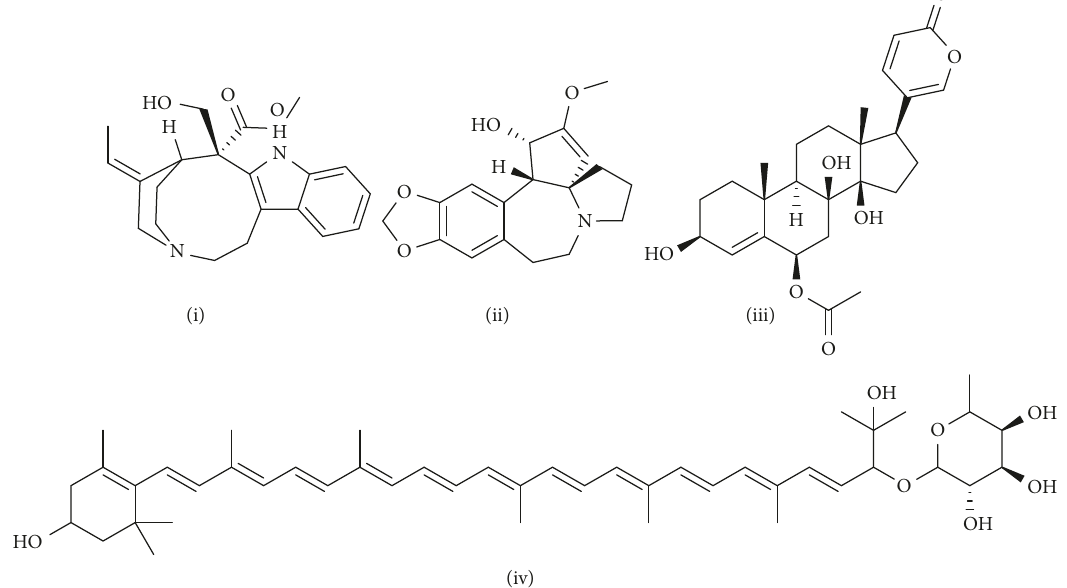
Figure 4: Structure of isolated compounds: (i) stemmadenine, (ii) cephalotoxin, (iii), scillirosidin, (iv) and myxoxanthophyll.